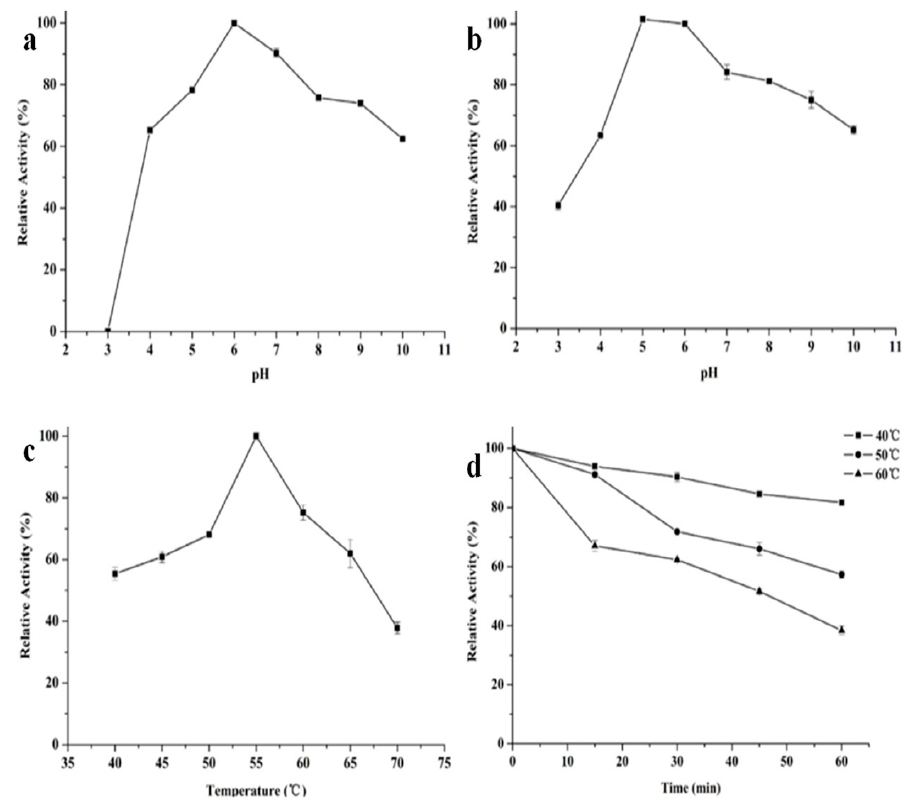
Figure 6. Influence of pH and temperature on the enzyme. ( a ) enzyme activity at different pH values; ( b ) pH stability of the enzyme; ( c ) enzyme activity at different temperatures; ( d ) thermostability of the enzyme.